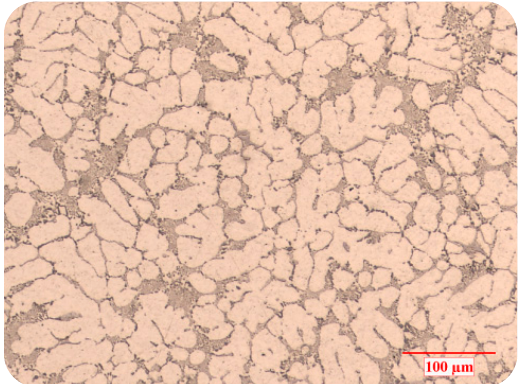
Table 1. General chemical composition of cast alloy from cast ingots.